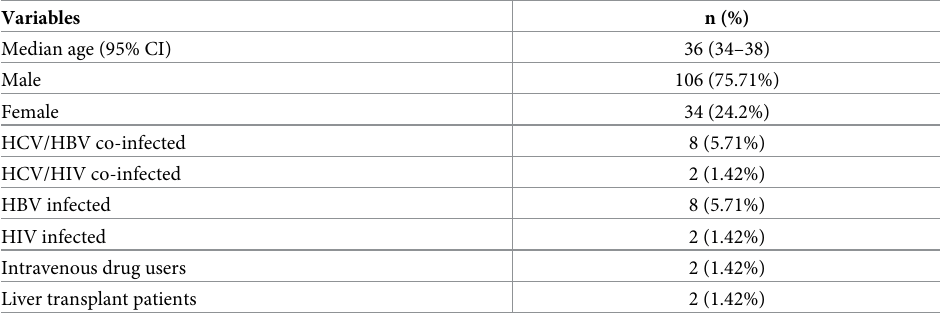
Table 2. Demographic characteristics of 140 enrolled